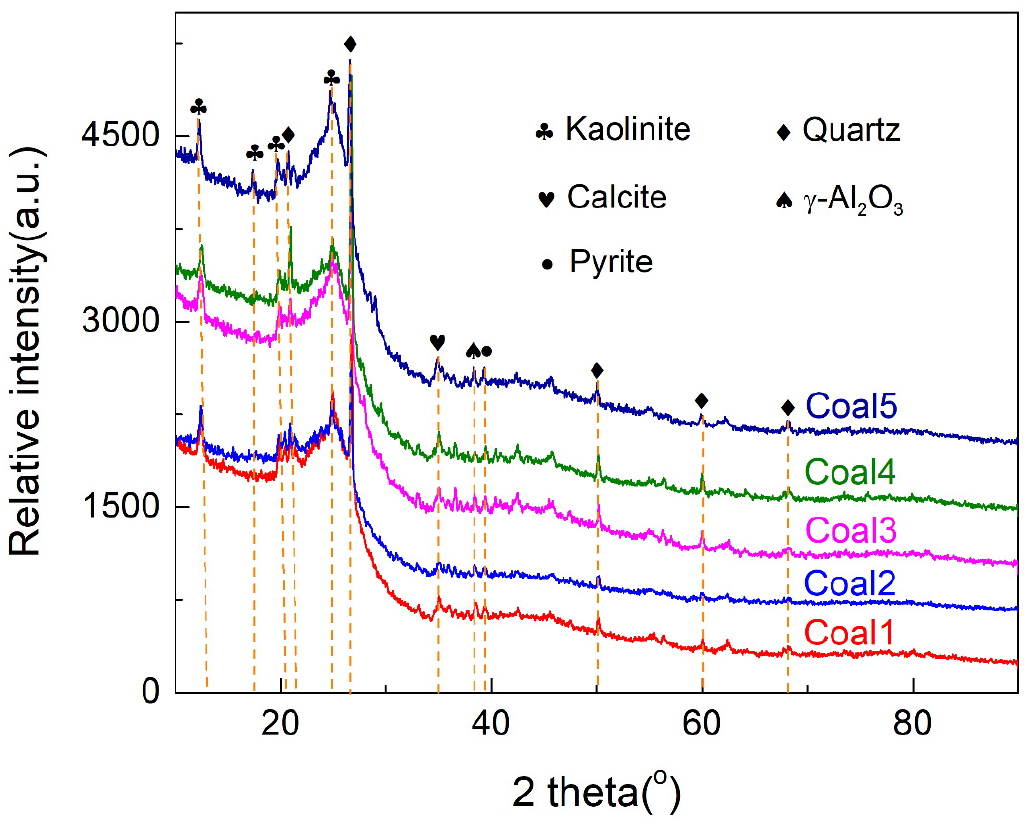
Figure 1. XRD patterns of different bituminous coal samples. Figure 2 depicts several prominent peaks fitted by Gaussian functions. The peaks of minerals (kaolinite and quartz) are also considered in this work to ensure accurate fitting of the data. The characteristic parameters ( f a , d 002 , L c ) obtained from the curve-fitting of the γ and 002 bands are plotted in Figure 3. According to Figure 3a, the aromaticity ( f a ) values from the different bituminous coal samples varied from 0.653 to 0.723, which